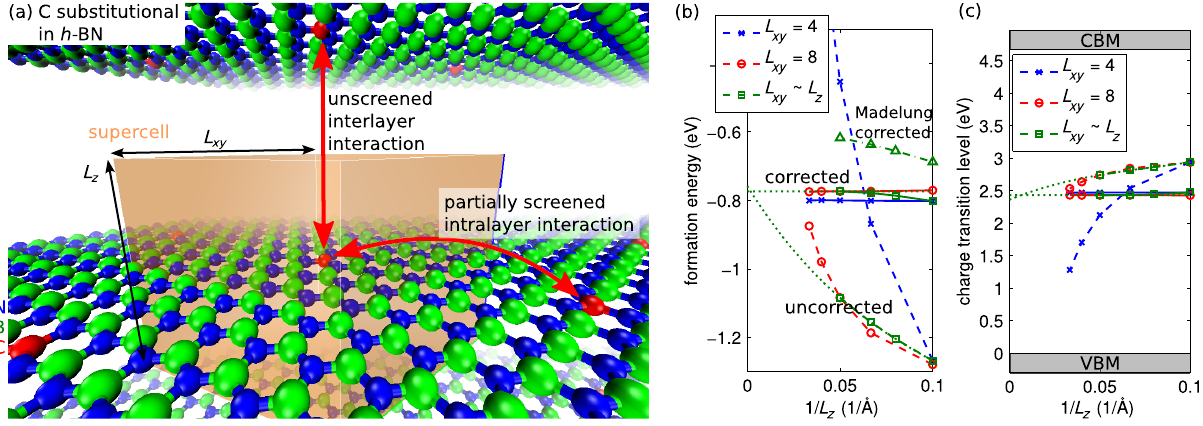
FIG. 1. (a) Schematic presentation of a supercell geometry for charged defect calculation in 2D materials by the example of positively ðþ 1 Þ in an h -BN sheet. The different types of interactions between defects are denoted by charged carbon substitutional impurity C B ðþ 1 Þ as a function of the inverse layer separation for two different fixed lateral sizes ( L arrows. (b) Formation energy of C B and 8 a , where a is the lattice constant) and for a system where all dimensions of the supercell are scaled uniformly ( L x ¼ L y ∼ L z , starting from L x ¼ L y ¼ 4 a , L z ¼ 10 Å). Both uncorrected (dashed lines) and corrected (solid lines) energies are shown. Application of Madelung correction within an effective medium is shown with a dash-dotted line. Extrapolations to an infinitely large supercell are also presented (dotted lines). (c) Charge transition levels ε ð 0 = þ 1 Þ for the same system sizes as in (b). The scale of the y axis is limited by the PBE band gap of BN (4.67